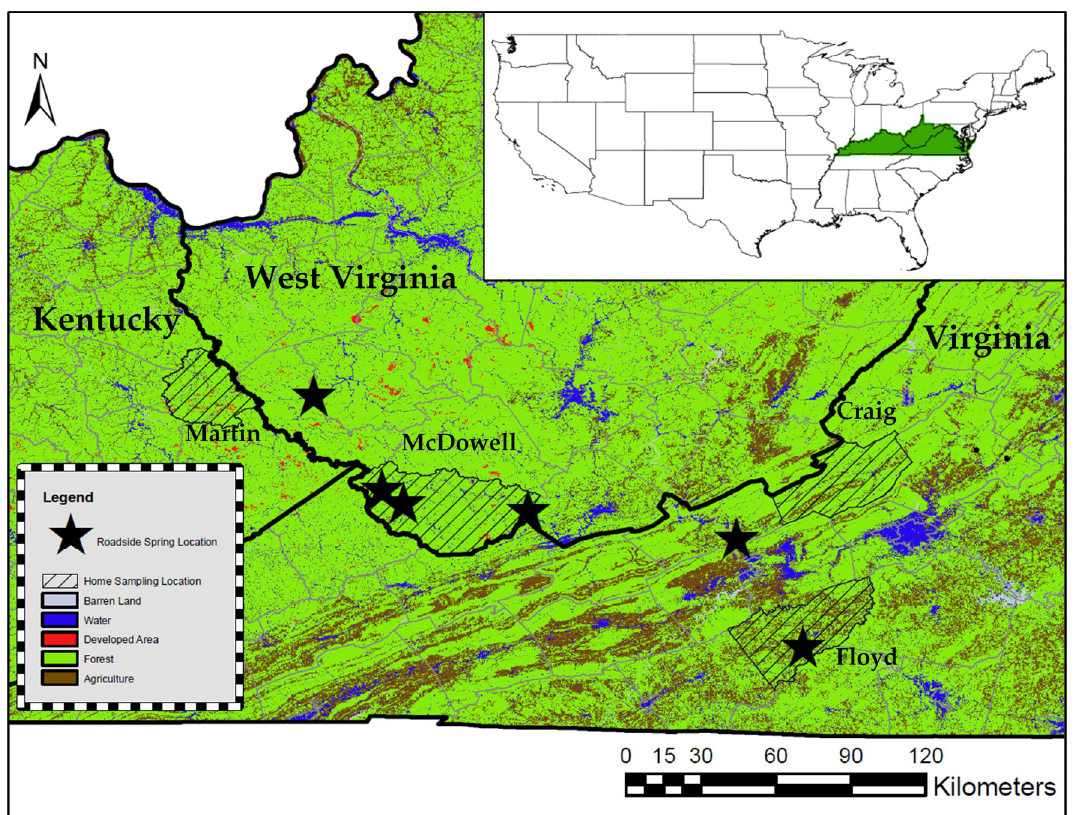
Figure 1. Map featuring the Central Appalachian region in relation to the United States, and the locations of roadside springs and household sampling.